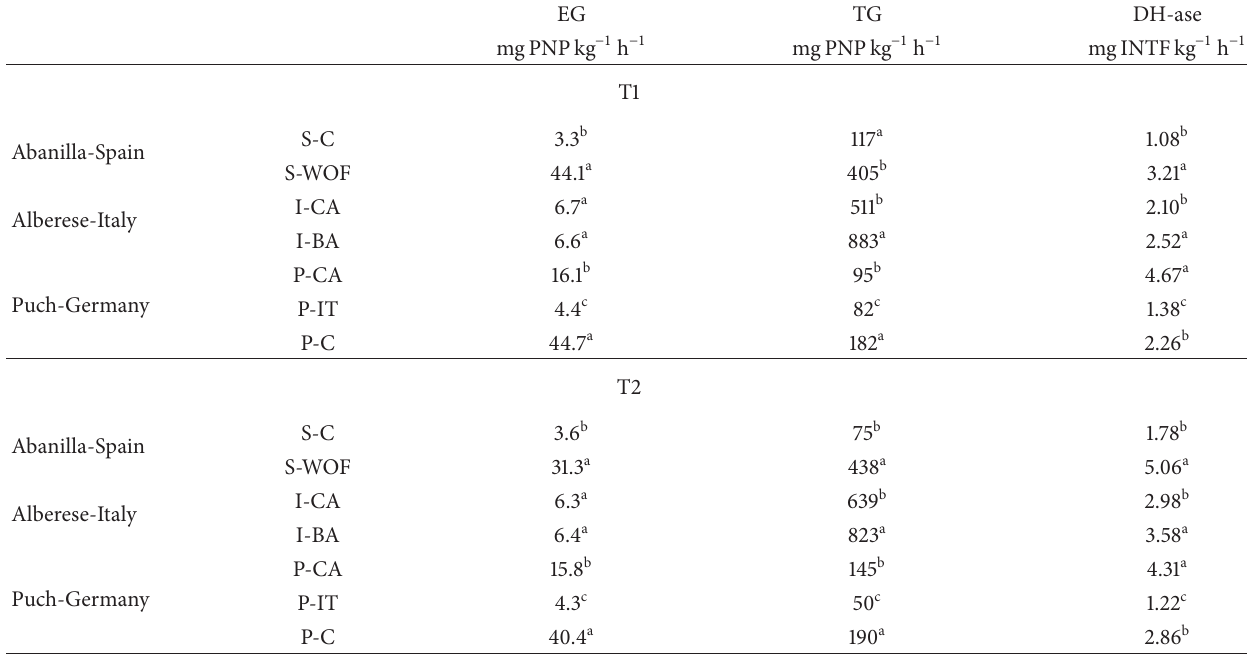
Table 2: Biochemical properties at T1 and T2 sampling times. For each site, different letters indicate statistically different values among the treatments ( 𝑃 < 0.05